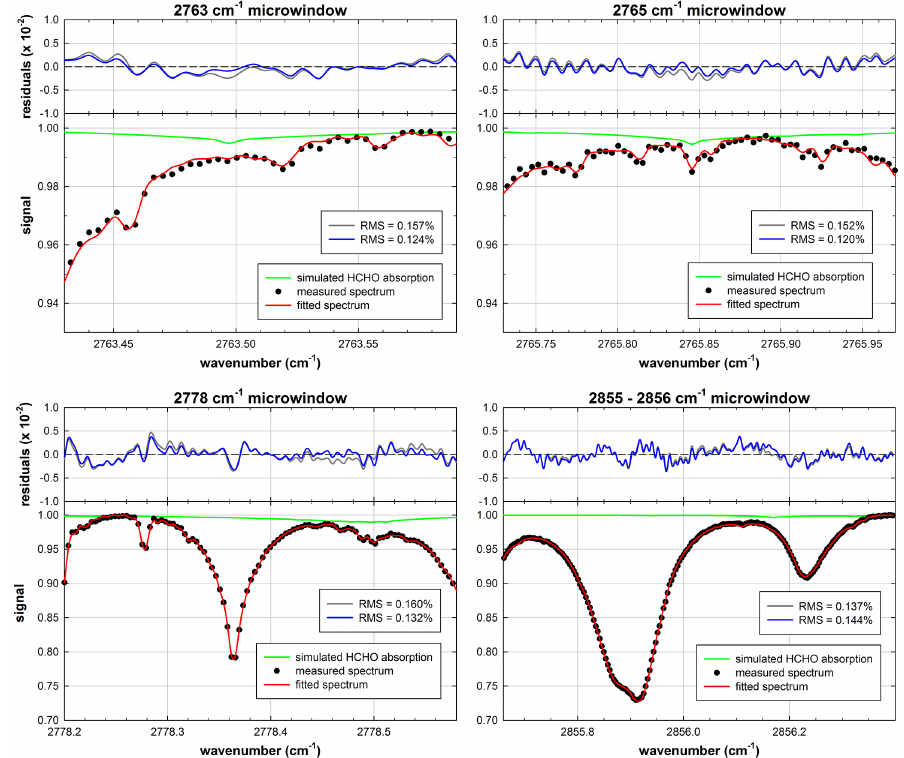
Figure 1. Typical example of HCHO FTIR spectral fits at ISSJ: 22 August 2010, 06:40UTC, with a SZA of 80 ◦ . The related residuals when fitting HCHO absorption and assuming no HCHO absorption are in blue and grey curves, respectively. This solar spectrum is characterized by a S/N ratio of 1656 and produced a DOFS equal to 1.02 and HCHO total column of 1 . 26 × 10 15 moleccm − 2 (compared to a S/N ratio of 1627, a DOFS of 1.05 and HCHO total column of 1 . 56 × 10 15 moleccm − 2 averaged over the whole FTIR July 2010–December 2012 data set). The solid green line corresponds the HCHO solar absorption simulated at the ISSJ for the same date and SZA. Note that this FTIR fit corresponds to the same date as the DOAS fit example in Fig. 2. This figure can be compared to Fig. S2, representing the same HCHO FTIR spectral fits but using the six microwindows from Vigouroux et al.